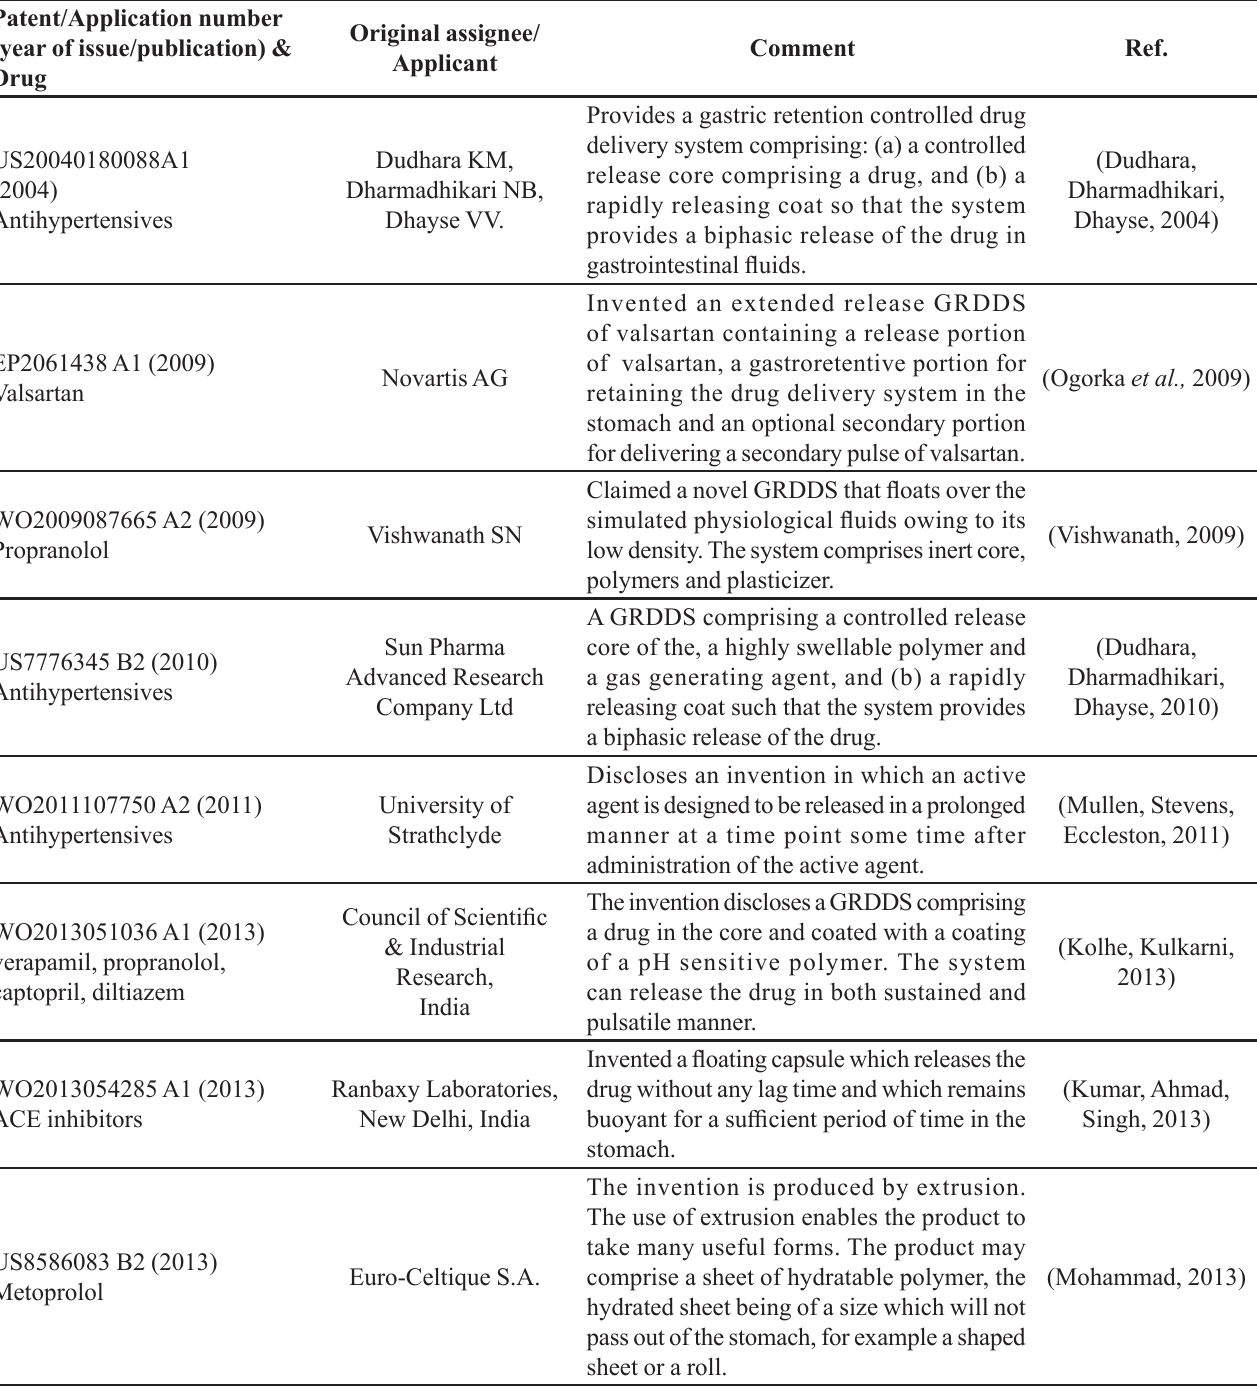
TABLE IV - Patents on grdds of antihypertensive